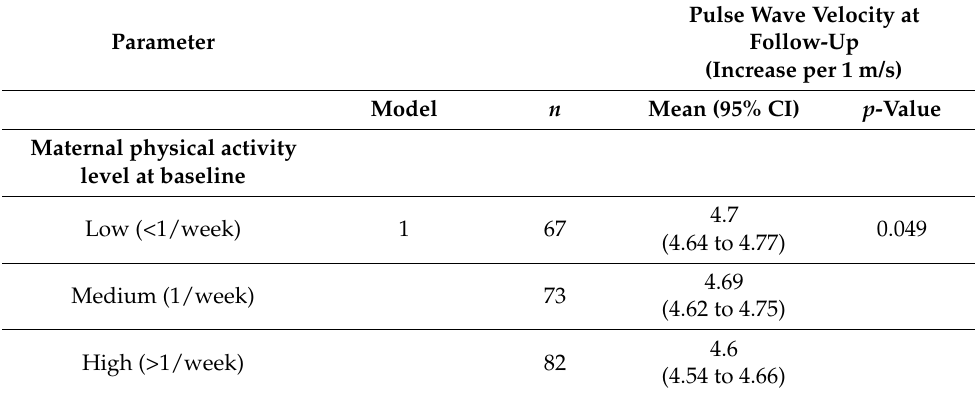
Table 3. Childhood pulse wave velocity in relation of categories of parental and familial physical activity